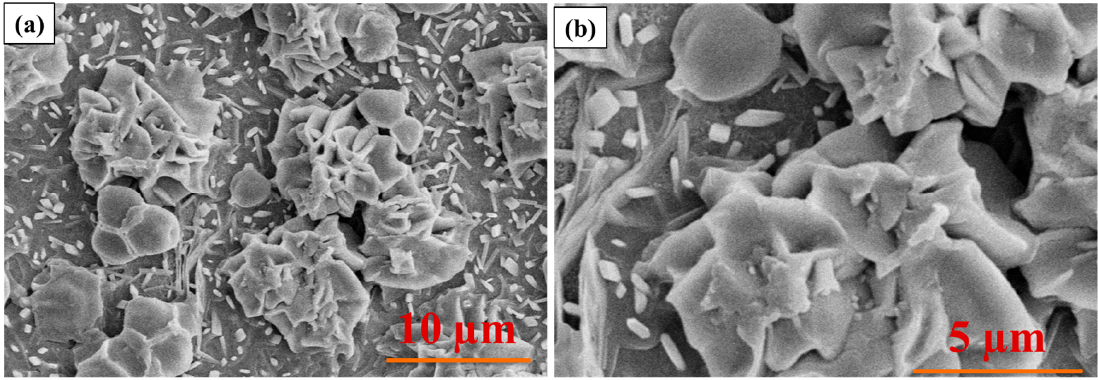
Figure 6. FESEM images ( a , b ) of the prepared thin film of MA 3 Sb 2 I 9 on the FTO substrate at different magnifications.